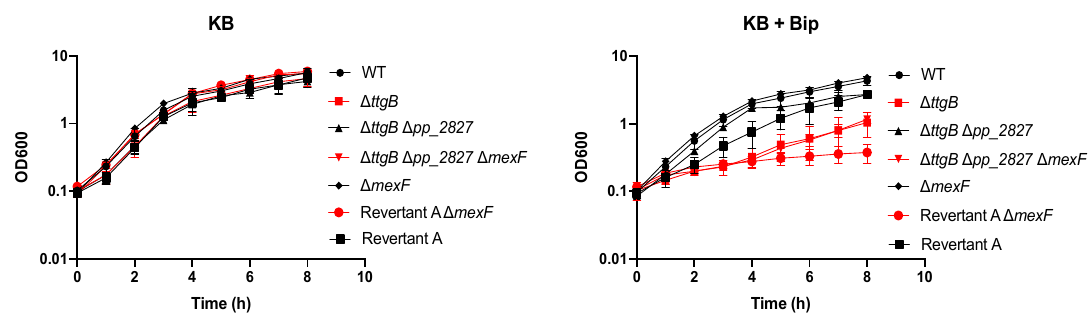
Figure 5. Growth of ∆ ttgB -derivative strains in presence of Bip is due to MexEF-OprN activity. Bacterial growth was analyzed through growth curves in KB medium supplemented with 0.5 mM Bip at 30 °C with continuous shaking (180 rpm). To that end, overnight cultures were used to inoculate 35 mL of medium (initial OD 600 of 0.1). Every 60 min, OD 600 was measured. Strains with phenotype similar to the original ∆ ttgB strain ( ∆ ttgB ∆ pp_2827 ∆ mexF and Revertant A ∆ mexF ) are shown in red. Data are presented as an average of three independent experiments. 3.4. The mexEF-oprN Operon is also Upregulated in Revertants B and C To obtain more information on the molecular basis of Bip resistance in the other revertant strains, we analyzed expression of the mexEF-oprN operon also in Revertant B and C and the engineered Δ ttgB Δpp_2827 strain using plasmid pBBR1- MCS5- P mex :: lux. Bioluminescence measurements revealed that all three strains expressed mexEF-oprN , although to different degrees (Figure 6). The higher expression of mexEF-oprN in the Revertant B can also be seen indirectly through the increase